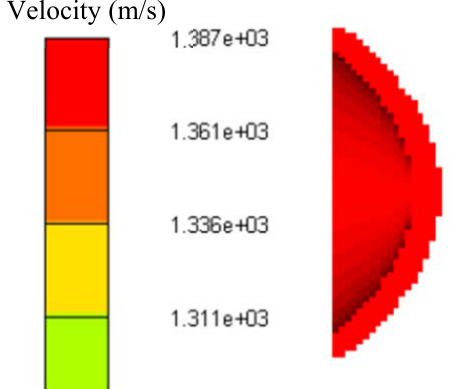
Figure 10. Penetrator velocity of EFP initiated by TNT, measured after 100 µs (Autodyn) [8]